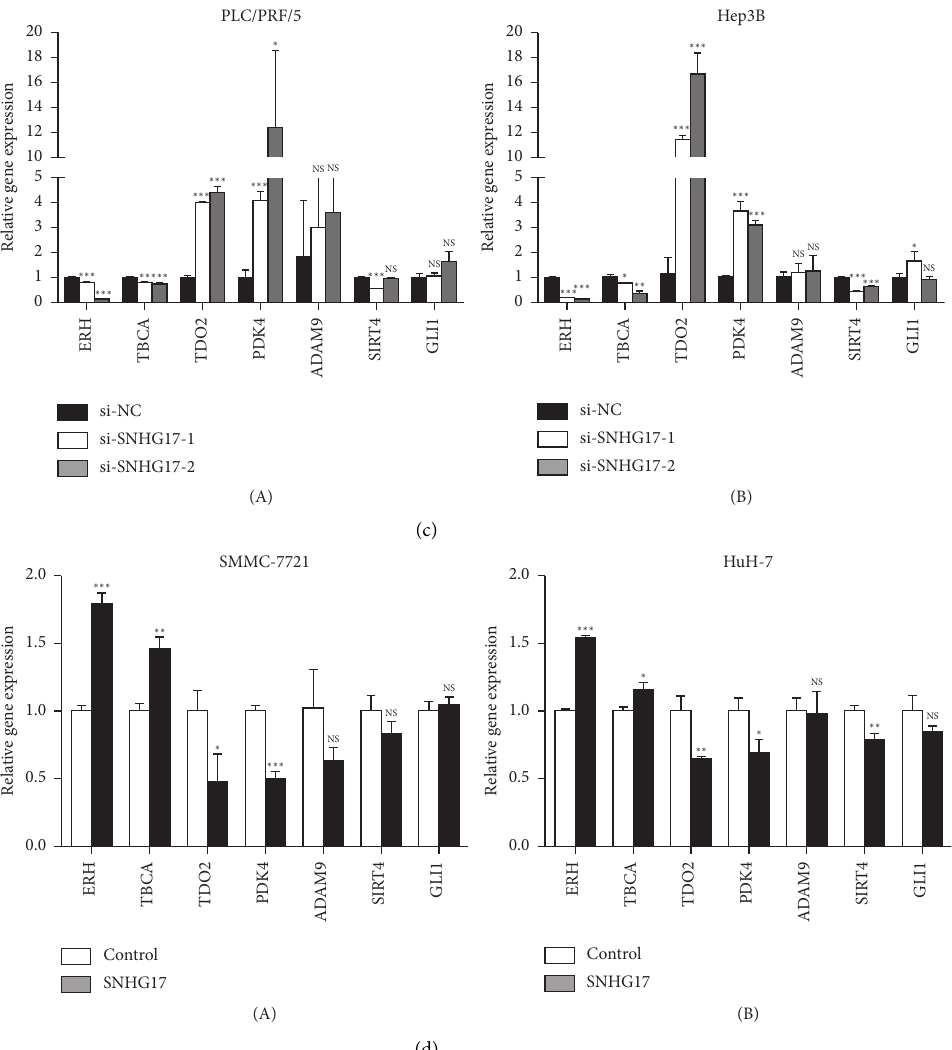
Figure 5: RNA sequencing and bioinformatics analysis explore the downstream genes regulated by SNHG17 in HCC. (a) Mean-centered, hierarchical clustering of 1037 genes altered ( ≥ 2-fold change, P < 0 . 05) after knockdown of SNHG17 in Hep3B cells, with three repeats. (b) The (A) Venn diagrams represent the overlap of downregulated genes in RNA-seq data and SNHG17-positive-related genes in TCGA- LIHC. The (B) Venn diagrams represent the overlap of upregulated genes in RNA-seq data and SNHG17-negative-related genes in TCGA- LIHC. (c) qRT-PCR was performed to detect the expression of indicated genes in (A) PLC/PRF/5 and (B) Hep3B cells. (d) qRT-PCR was performed to detect the expression of indicated genes in (A) SMMC-7721 and (B) HuH-7 cells. ∗ P < 0 . 05, ∗∗ P < 0 . 01, ∗∗∗ P < 0 . 001, and NS, not